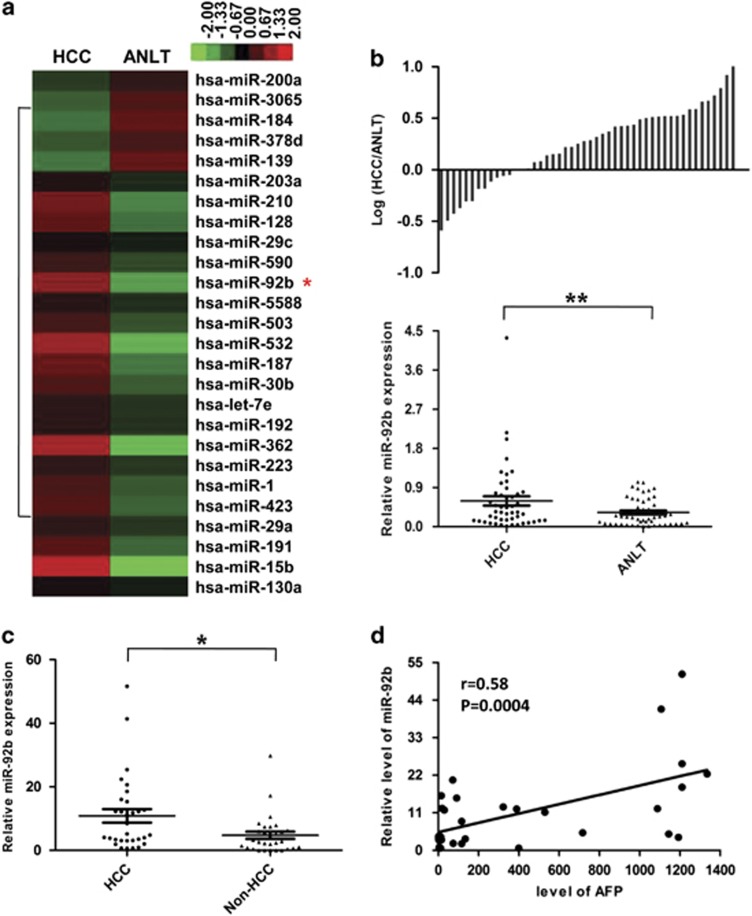
Expression levels of miR-92b in HCC tissues and plasma samples. (a) Partial miRNAs expression profiles of HCC tissues and ANLTs. Red or green color in heatmap separately indicates high or low expression, according to the color bar in logarithmic scale shown above the heatmap. (b) Expression levels of miR-92b in 48 pairs of HCC tissues and ANLTs were determined by qRT-PCR and normalized to U6 expression. The data were analyzed by delta Ct method. Upper panel: The bars represent the relative miR-92b expression with the ratio of its level in HCC tissue versus ANLT in logarithmic scale. Lower panel: The miR-92b expression levels in HCC tissues and ANLTs were compared with paired Student's t-test. (c) miR-92b levels in the plasma of HCC patients (n=31) and patients without liver diseases (n=29). The expression levels were compared with unpaired Student's t-test. (d) The positive correlation between AFP and miR-92b levels in the plasma of HCC patients (r=0.58, P=0.0004, n=31). *P<0.05; **P<0.01